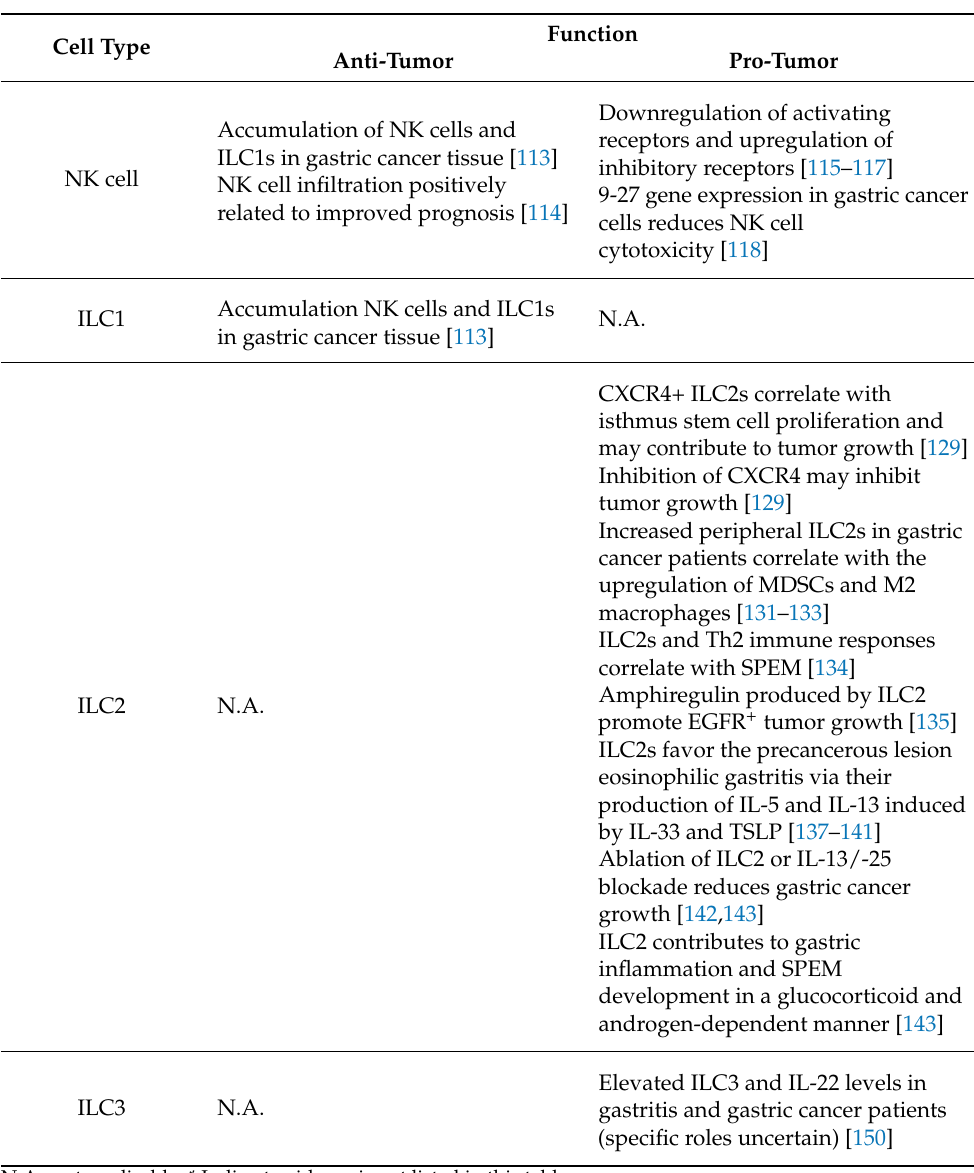
Table 1. Roles of ILCs in Promoting or Inhibiting Gastric Oncogenesis